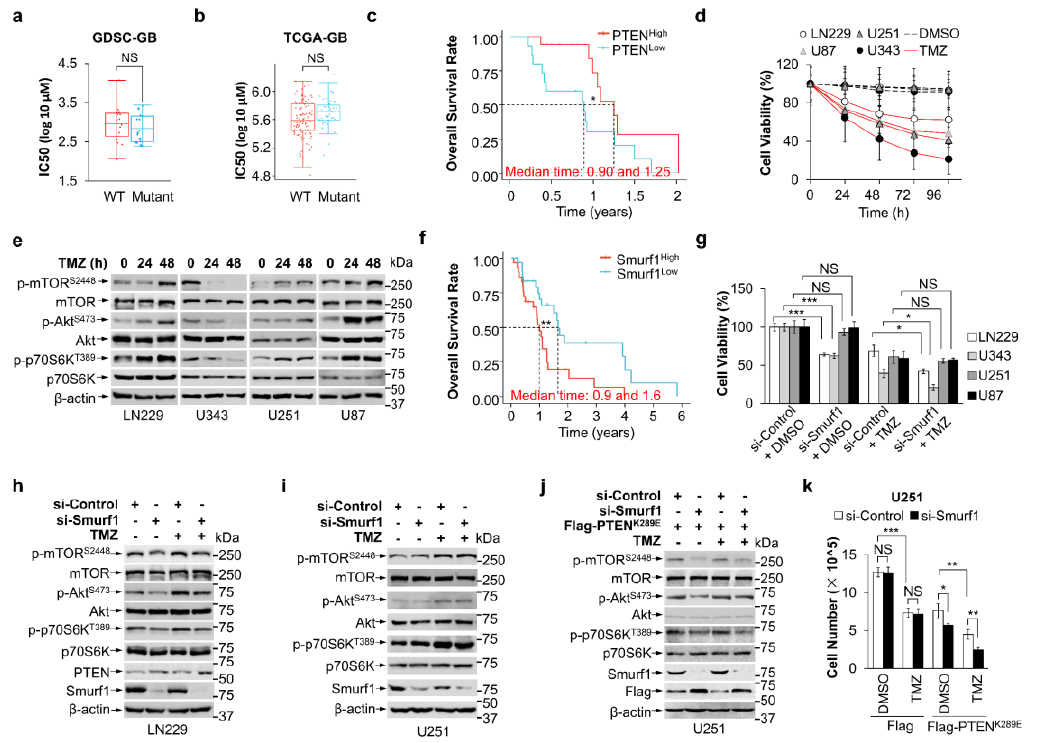
Figure 1. Combination of Smurf1 suppression with TMZ synthetically inhibits PI3K/Akt pathway. ( a ) The distribution of IC50 score for TMZ in different PTEN status GB cell lines. The IC50 for